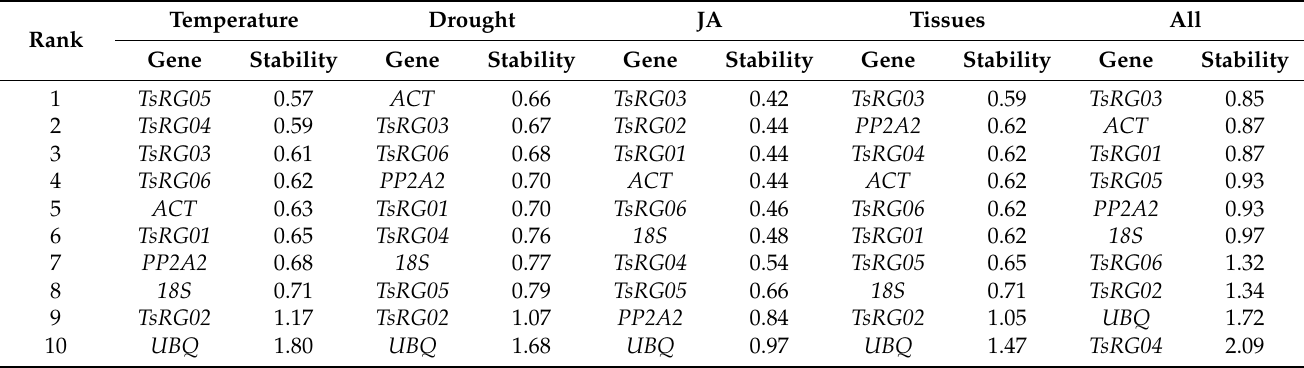
Table 4. Expression stability of 10 candidate RGs under different conditions were calculated by ∆ Ct.